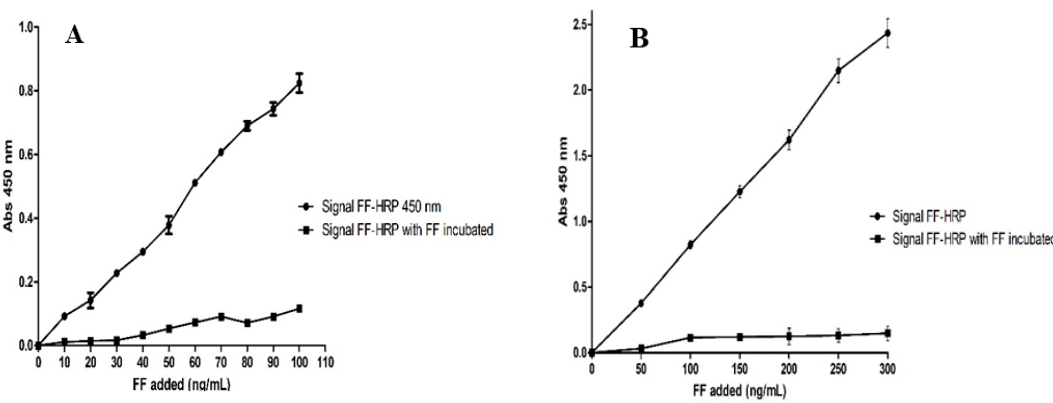
Figure 4. Competition between HRP-FF and free FF for binding to immobilized FF-nanoMIPs ( A ) 10–100 ng/mL concentrations and ( B ) 50–300 ng/mL concentration of FF.